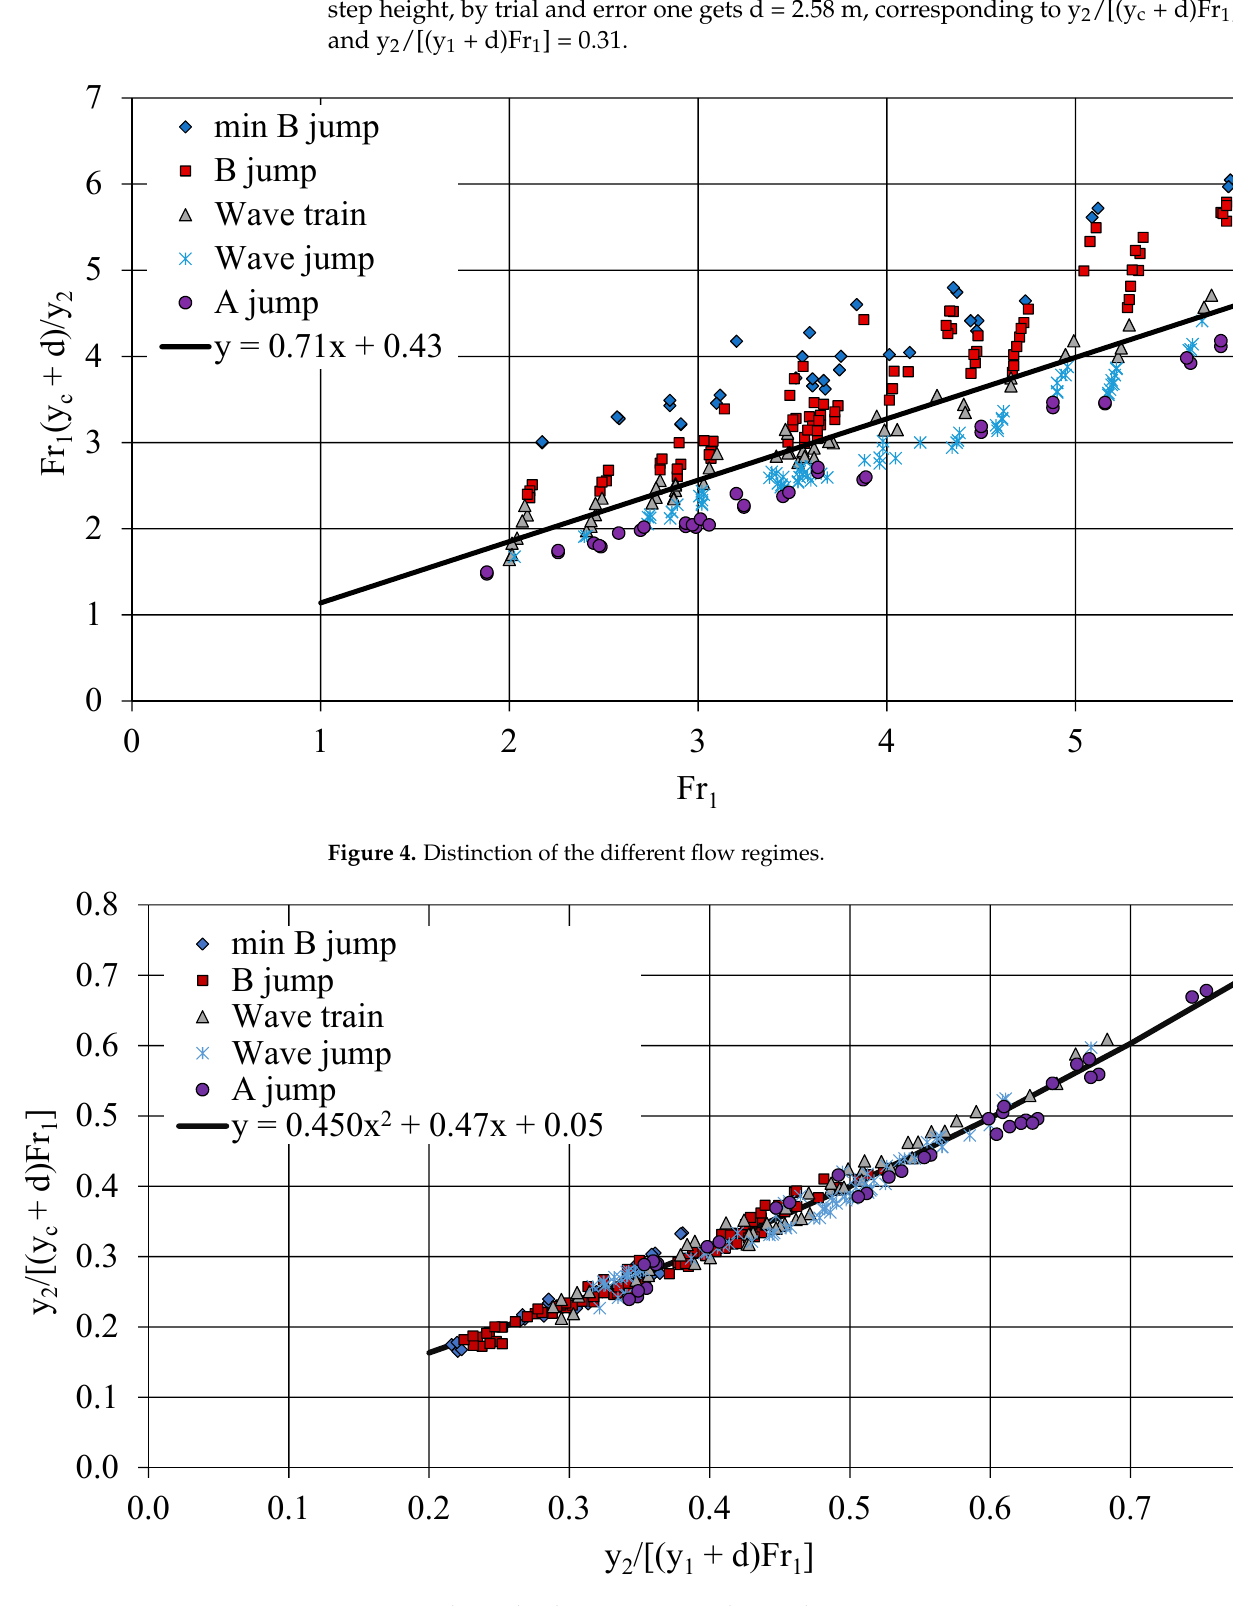
Figure 6. Normalized energy loss at the step ΔΗ /y c versus Fr 1 (y c + d)/y 2 .